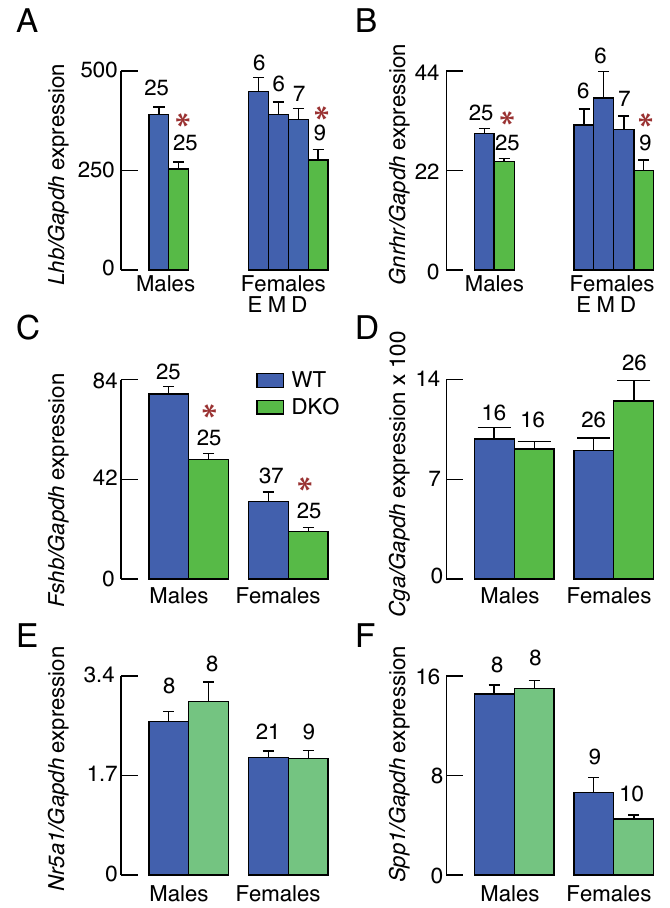
Figure 3. Selective effects of DKO on gonadotroph-specific gene expression. ( A – F ) Gene expression in male and female WT and DKO mice: Lhb (A), Gnrhr (B), Fshb (C), Cga (D), Nr5a1 (E), and Spp1 (F). Results for WT females were derived from animals in estrus (E), metestrus (M) and diestrus (D) stage of estrous cycle (A and B), or from random cycling animals (C–F). The data shown are mean ± SEM values and the numbers of replicates are indicated above the bars. Asterisks, P < 0.01 between DKO and each control group (A and B) or between pairs